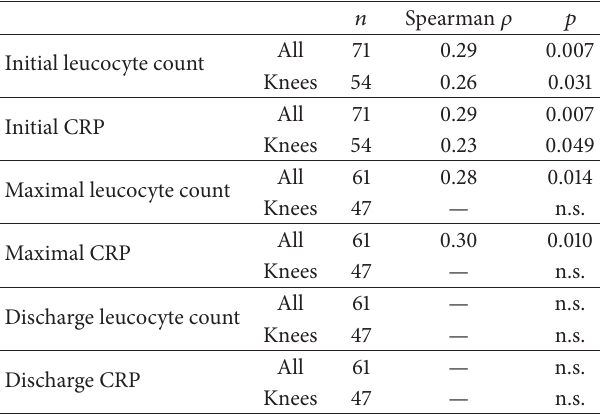
Table 2: Association of relative intra-articular IL-1 𝛽 levels with systemic inflammatory parameters (n.s.: not